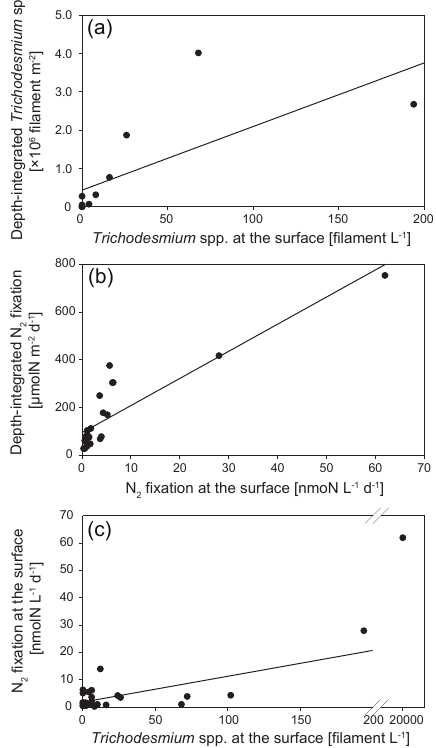
Figure 6. Relationships (a) between surface and depth-integrated Trichodesmium spp. abundance, (b) between surface and depth- integrated nitrogen fixation rates, and (c) between Trichodesmium spp. abundance and nitrogen fixation rate at the